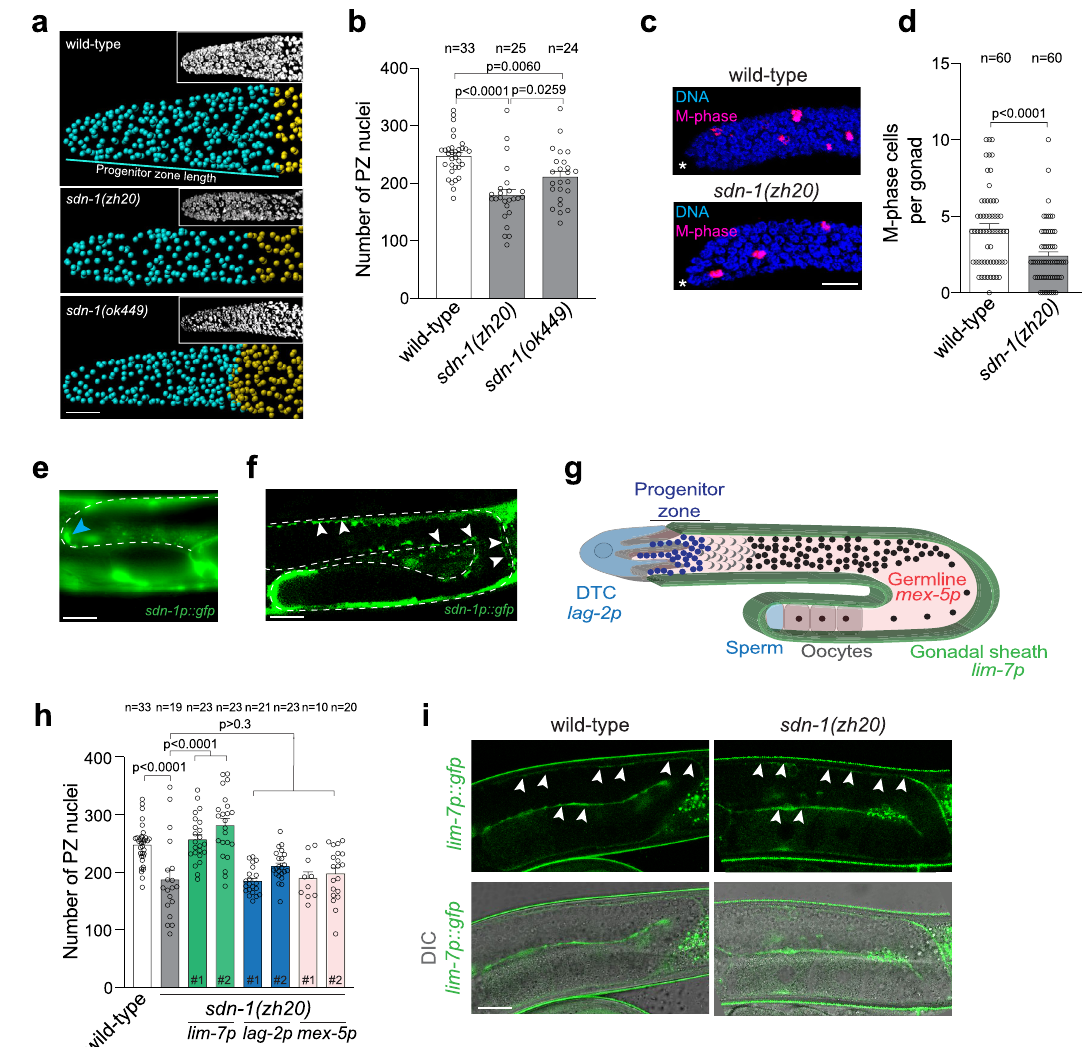
Fig. 1 SDN-1 controls germ cell proliferation from the somatic sheath. a , b 3D germline analysis images ( a ) and quanti fi cation ( b ) of germline progenitor zone (PZ) nuclei (cyan spheres) in wild-type, sdn-1(zh20) , and sdn-1(ok449) adult hermaphrodites. Insets in ( a ) = Confocal image of DAPI staining. 3D models are generated in Imaris. Transition zone nuclei are represented as gold spheres. Data were expressed as mean ± s.e.m. and statistical signi fi cance was assessed by ordinary one-way ANOVA. Scale bar = 10 µ m. c , d Immunostaining images ( c ) and quanti fi cation ( d ) of M-phase cells in distal